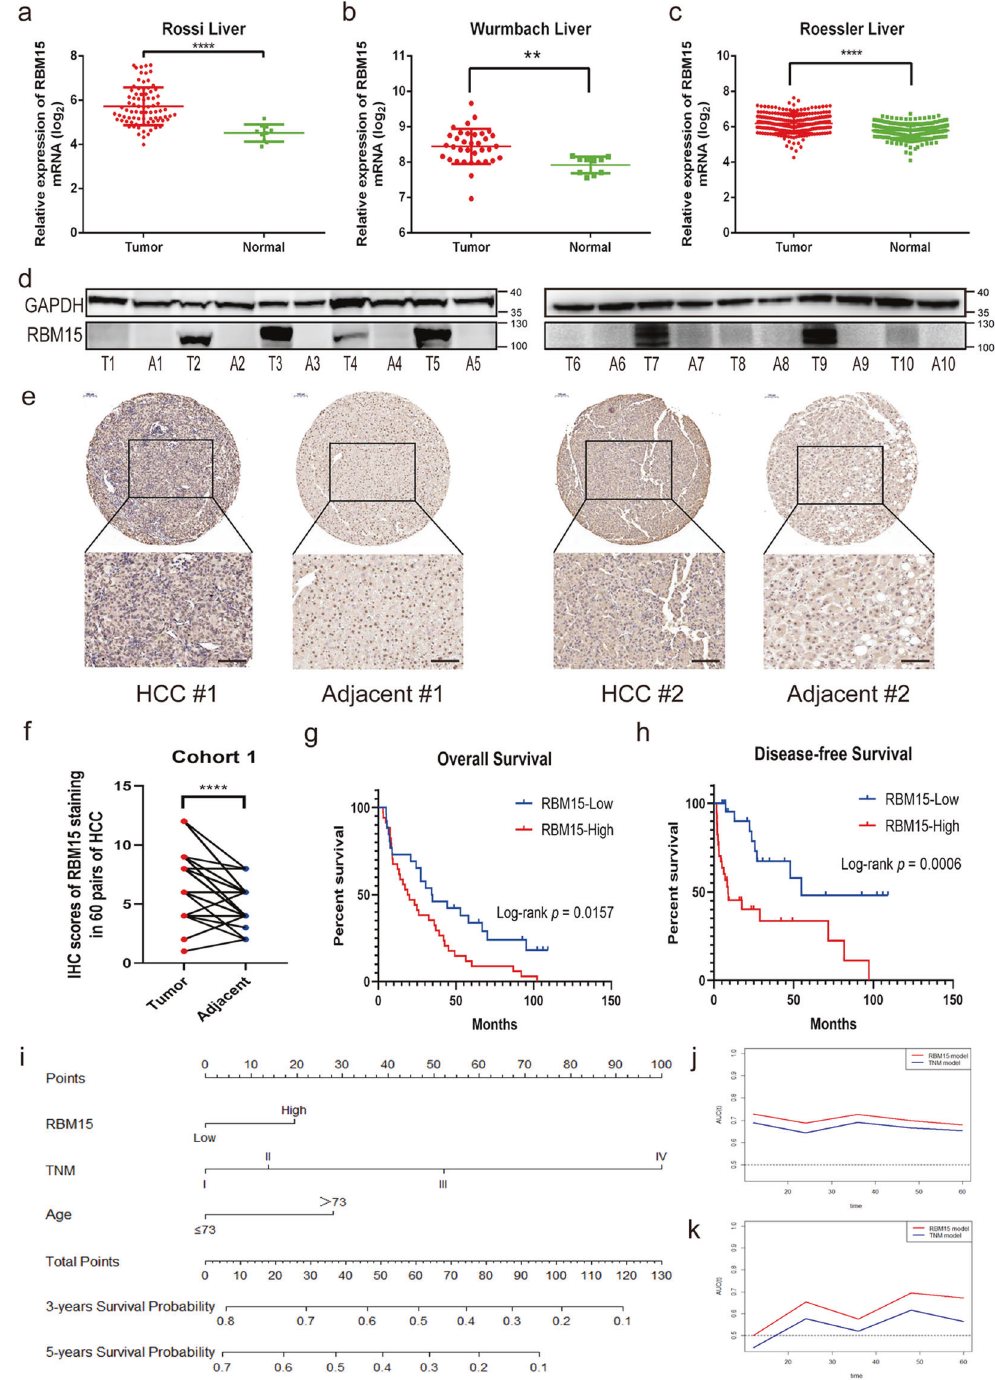
Fig. 2 High-expression of RBM15 is associated with poor outcomes of HCC. a – c The expression of RBM15 mRNA was compared between tumors and normal tissues based on GEO datasets (GSE14520, GSE62232, and GSE6764; ** p < 0.01, **** p < 0.0001; t test); d the expression of RBM15 protein was analyzed in ten pairs of HCC tissue (T: tumor; A: adjacent tissue); e representative IHC images of RBM15 staining in tumor and adjacent tissues of cohort-1 patients (scale bar, 100 μ m; magni fi cations, ×100 and ×200); f IHC scores of matched tumors and adjacent tissues of cohort-1 were calculated based on RBM15 staining (**** p < 0.0001; t test); g Kaplan – Meier analysis of overall survival of cohort-1 patients based on RBM15 expression; h Kaplan – Meier analysis of disease-free survival of cohort-1 patients based on RBM15 expression; i nomogram to predict 3- and 5-year overall survival. Each risk factor corresponded to a point by drawing a line straight upward to the points axis. The sum of the points located on the total points axis showed the probability of overall survival by drawing a line straight down to the survival axis. j The time-dependent ROC curves comparing the RBM15 model with the TNM model based on the training group (cohort-2); k the time-dependent ROC curves comparing the RBM15 model with the TNM model based on the validation group (cohort-1). The data are presented as mean ±